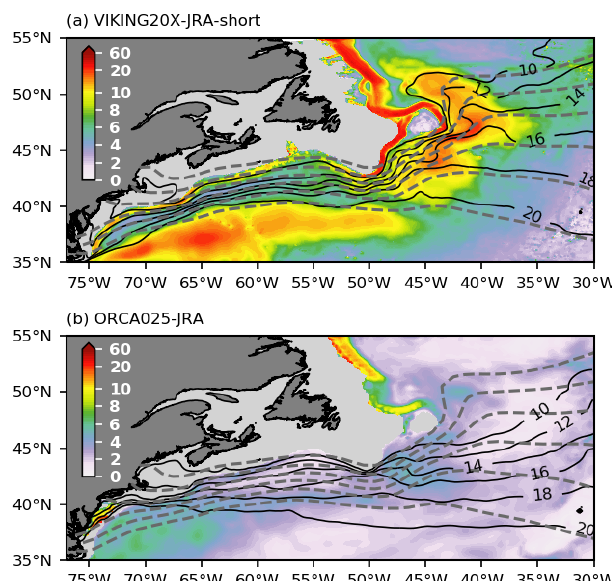
Figure 12. Path of the DWBC (speed on density range; see Fig. 7) and SST in degrees Celsius (solid contours) for (a) VIKING20X- JRA-short and (b) ORCA025-JRA. SST from the HadiSST dataset (Rayner et al., 2003) is shown by dashed